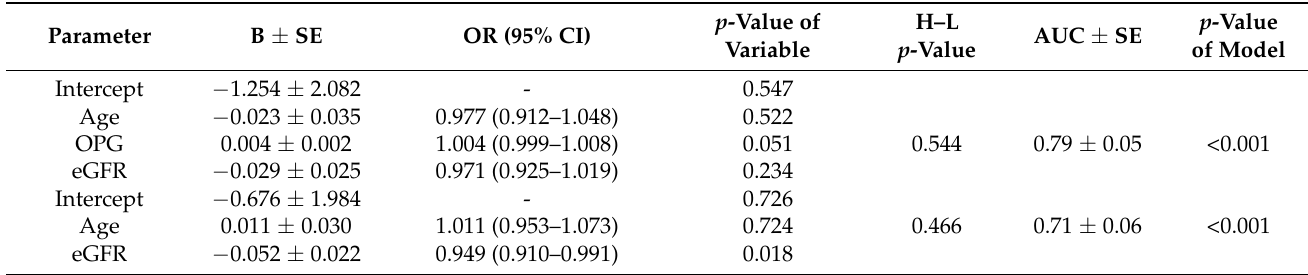
Table 4. Markers associated with protein energy wasting in chronic kidney disease patients based on a logistic regres- sion model.